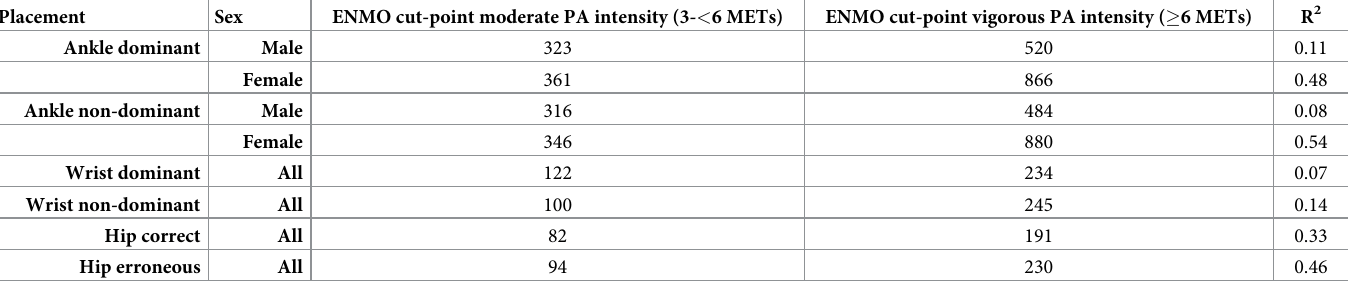
Table 3. Accelerometer cut-points for moderate and vigorous physical activity derived from treadmill experiments. Euclidian Norm Minus One in milligravity of 60-sec intervals sampled at 1-sec